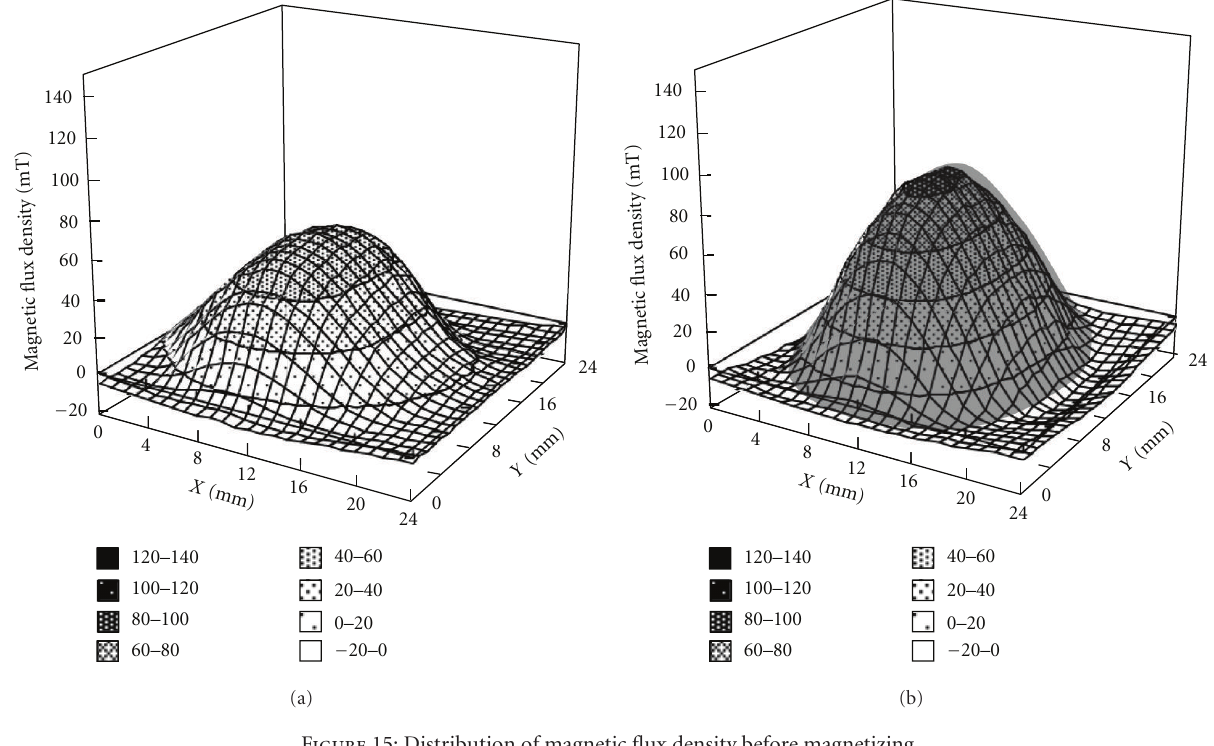
Figure 15: Distribution of magnetic flux density before magnetizing.